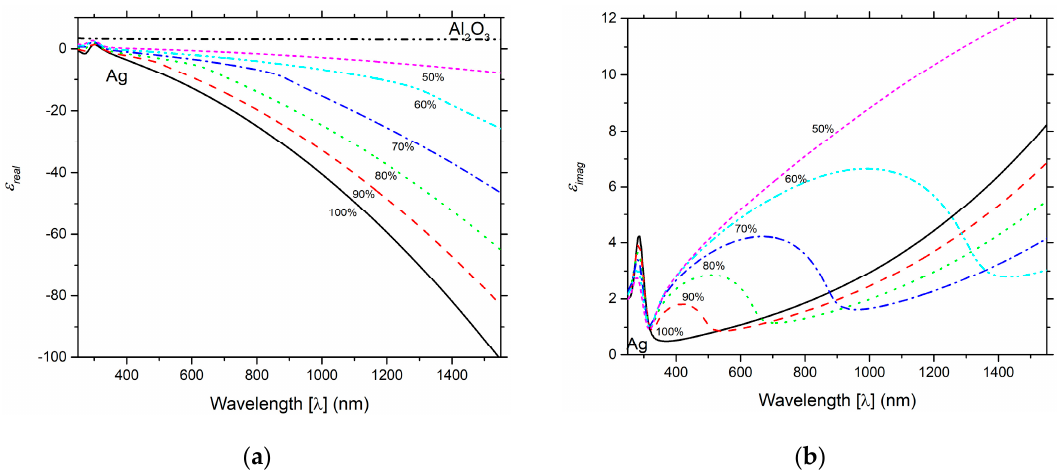
Figure 8. Complex dielectric ( a ) real part and ( b ) imaginary part of the metamaterial for concentrations of: 50% (small dashed curve), 60% (dash-double dotted curve), 70% (dash-dotted curve), 80% (dotted curve), 90% (dashed curve), and Ag of 100% (solid curve, corresponding to pure silver).